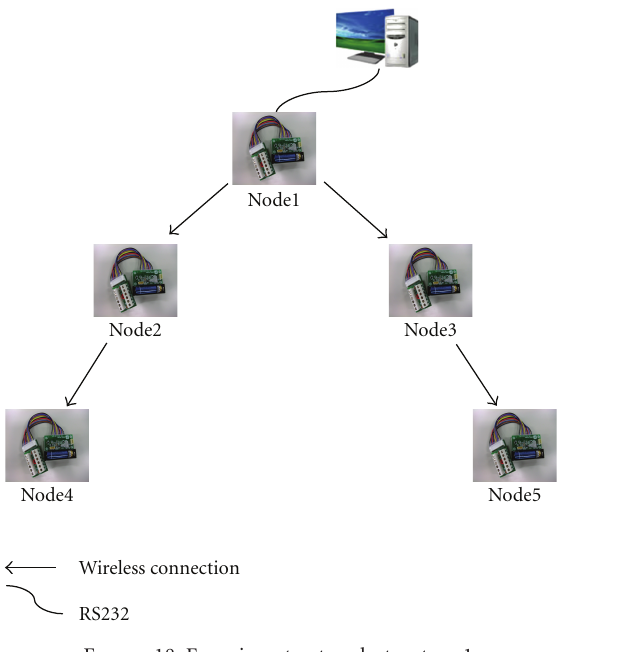
Figure 18: Experiment network structure 1.